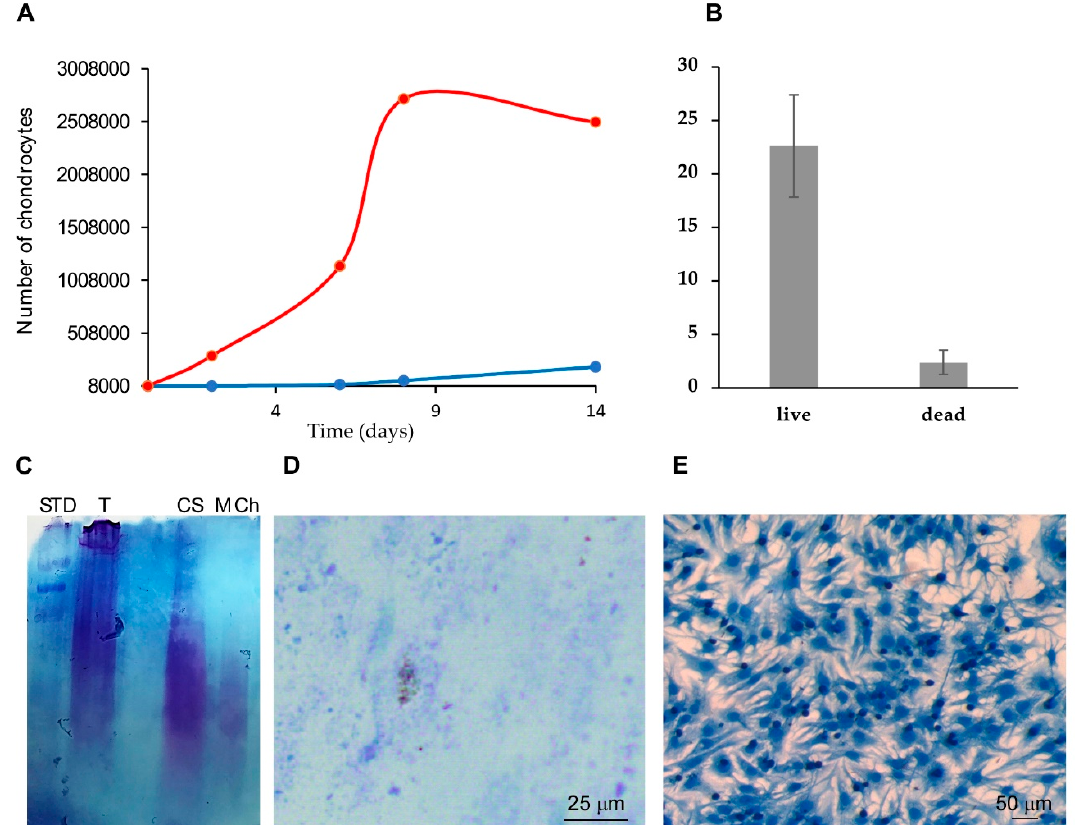
Figure 6. Chondrocytes in MCh are viable and produce glycosaminoglycan (GAG). ( A ) Proliferation assay of chondrocytes in 3D within MCh (blue curve) and in monolayer (red curve). ( B ) Viability evaluation by Trypan Blue staining the cells grown within the MCh for 14 days. NCs showed 90% of viability Bars represent mean ± SD ( n = 3). ( C ) Electrophoretic analysis of the matrix extracted from MCh after 14 days of NCs culturing. SDS-PAGE were stained with Alcian Blue (STD: molecular weight marker); T: Digested Bovine cartilage; CS: Chondroitin Sulfate control; MCh: Digested MCh after 14 days of NCs culturing. ( D ) Light micrograph of NCs growth within MCh for 14 days, stained with Alcian Blue. Magnification was 20 × . Scale bar was 25 µ m. ( E ) Chondrocytes resumed after hydrogel digestion and seeded in 2D conditions on a plate. Cell proliferation was very slow inside MCh; after, seeding cells started to proliferate and reached confluence after a few